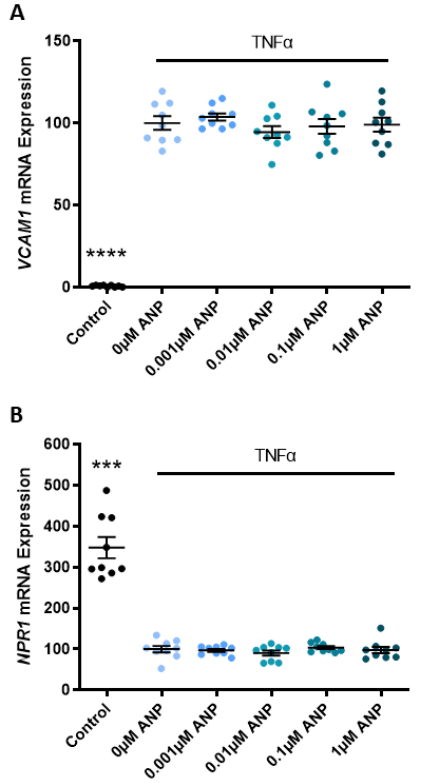
Figure 6. ANP does not reduce the expression of endothelial dysfunction marker VCAM1 in a model of endothelial dysfunction. In a model of endothelial dysfunction, TNF α signi fi cantly increases the expression of VCAM1 mRNA ( A ) and signi fi cantly decreases the expression of NPR1 mRNA ( B ) in HUVECs. Incrementally increasing doses of ANP did not mitigate the TNF α -induced change in VCAM1 ( A ) or NPR1 ( B ) mRNA expression. Data are mean ± SEM, n = 9, *** p < 0.001, **** p < 0.0001.